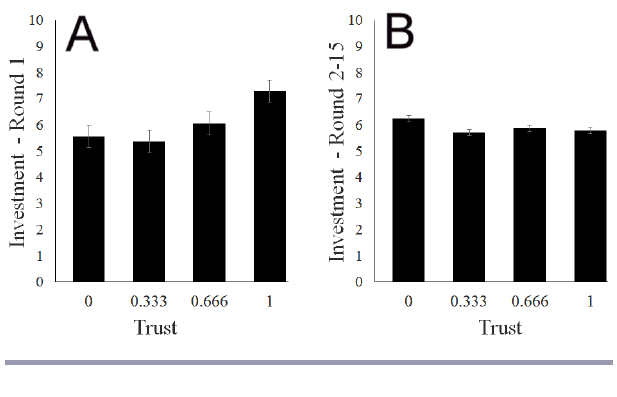
Fig. 4 . Average tokens invested depending on trust (thin bars represent standard error).